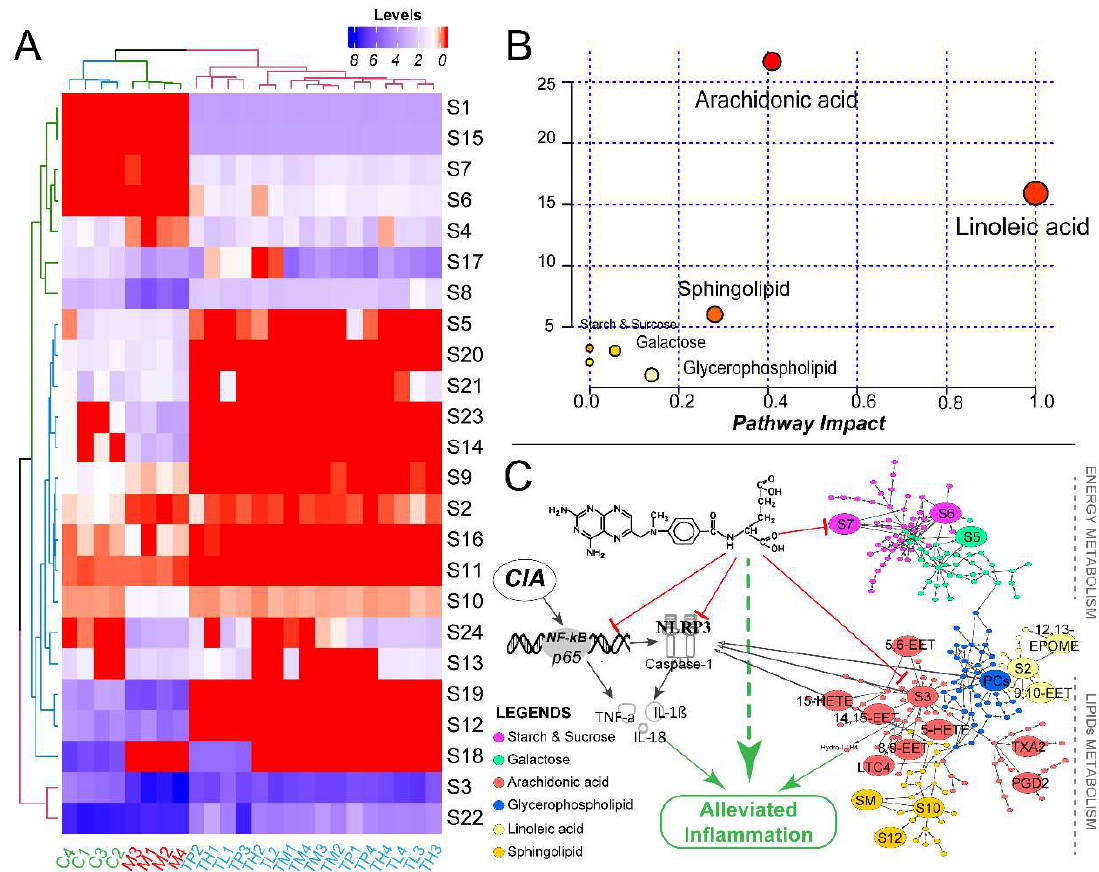
Figure 11. Differentiated metabolites and perturbed metabolic pathways. ( A ) The heatmap of all differentiated metabolites. ( B ) Results of metabolic pathways produced by MetaboAnalyst 4.0. The